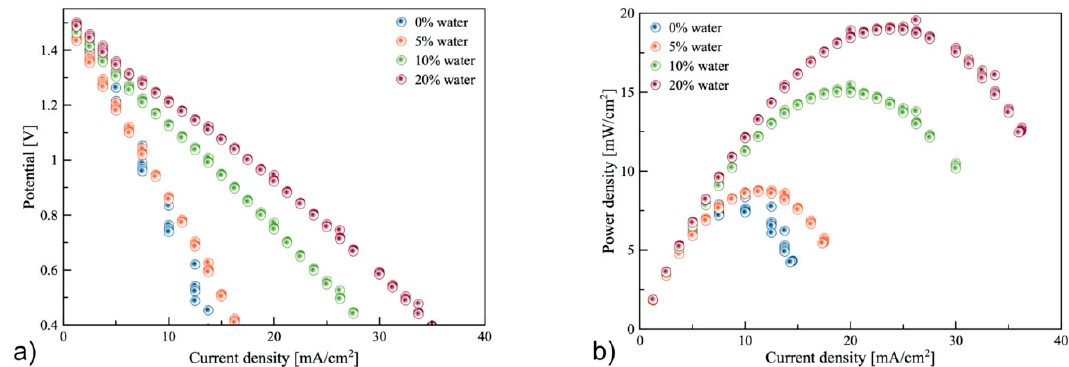
Figure 5. ( a ) Polarization characteristics of the dual-electrolyte Al–air battery using an anolyte of methanol solutions containing 3 M KOH with different ratios of water (0%, 5%, 10%, and 20% (v/v)). ( b ) Power density as a function of current density for the dual-electrolyte Al–air battery using an anolyte of methanol solutions containing 3 M KOH with different ratios of water (0%, 5%, 10%, and 20% (v/v)). Table 3. The maximum current density, power density, and internal resistance of the dual-electrolyte AAB using an anolyte of methanol solutions containing 3 M KOH with different ratios of water (0%, 5%, 10%, and 20% (v/v)).